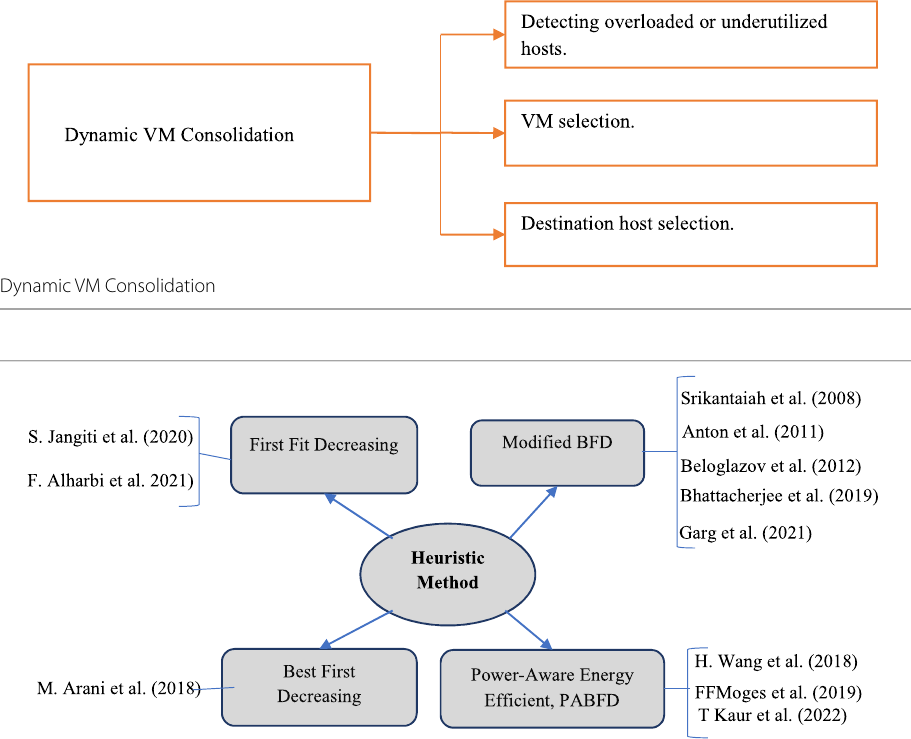
Fig. 5 Classification of existing research using a Heuristic